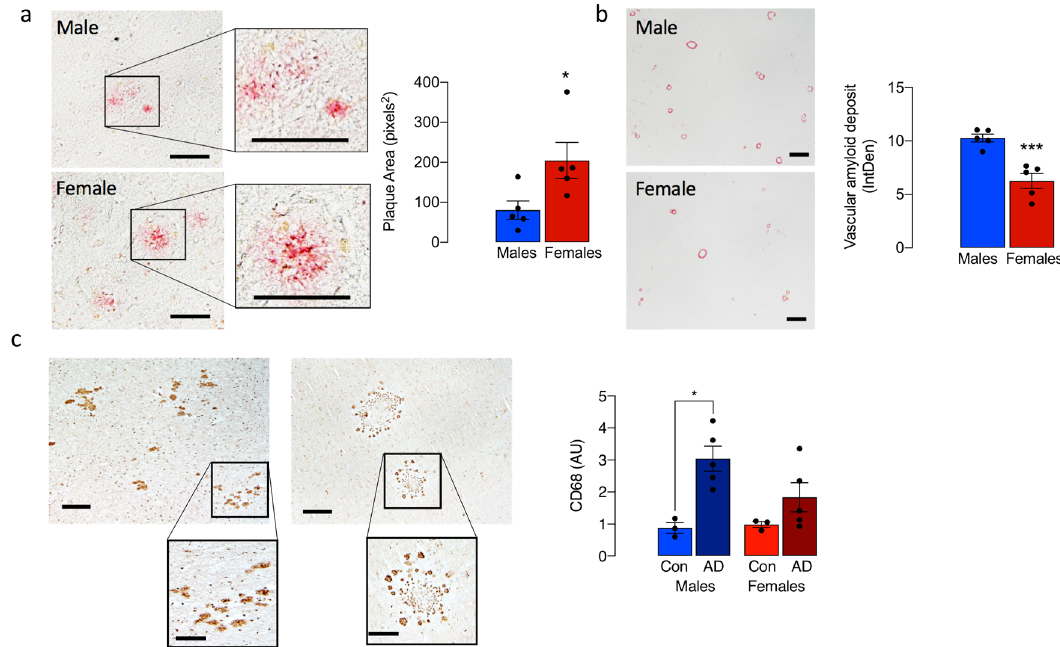
Fig. 8 Amyloid accumulation is signi fi cantly greater in post-mortem tissue from female compared with male AD patients. a Congo red staining in the parenchyma was more pronounced in parietal cortical tissue from female, compared with male, AD patients and plaque area was signi fi cantly increased (* p < 0.05; n = 5; scale bar = 100 μ m). b Vascular amyloid staining was signi fi cantly greater in sections prepared from male AD patients compared with females (*** p < 0.001; n = 5; scale bar = 400 μ m). c CD68 immunoreactivity was signi fi cantly greater in parietal cortex from male, compared with the female, AD patients (* p < 0.05, 1-tailed t -test; n = 4 except for AD females where n = 5; scale bar = 100 μ m; magni fi ed image, 50 μ m). Data, expressed as